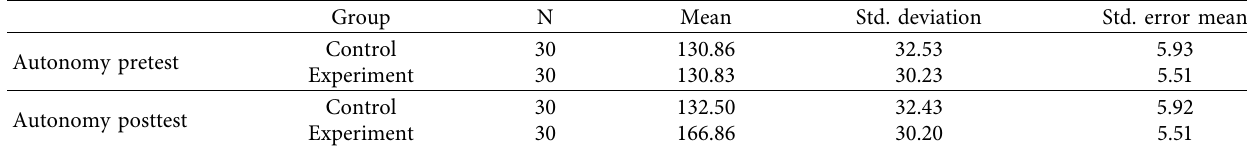
Table 3: Group statistics.